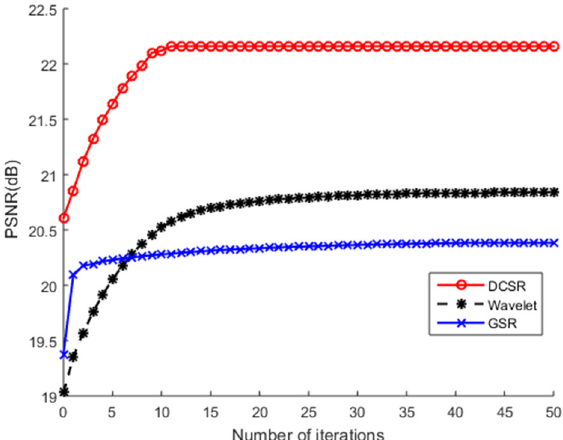
Figure 12. PSNR values of the Cameraman grayscale image recovered by four competing methods as a function of the number of iterations. The test image is corrupted by salt and pepper noise.